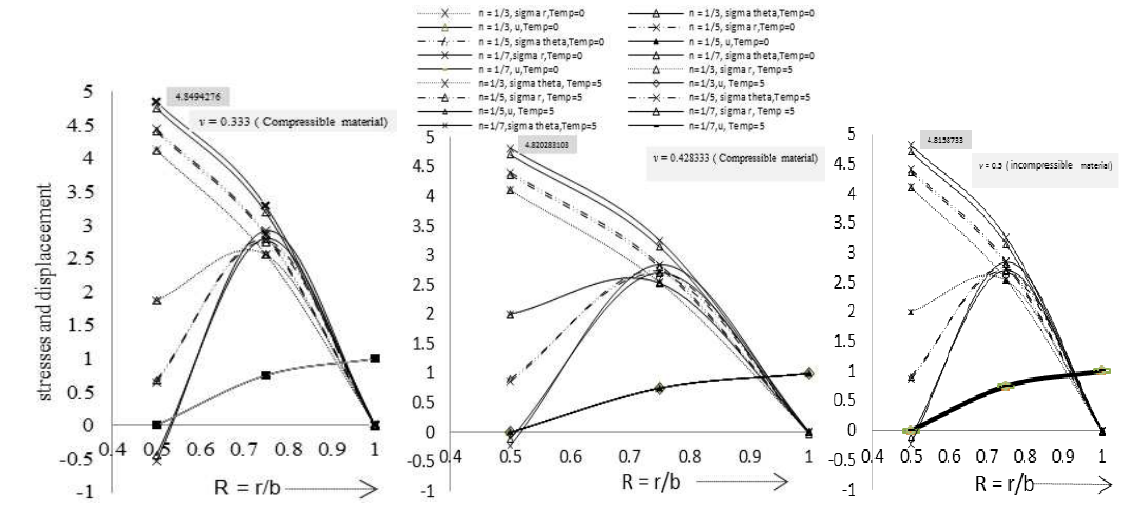
Figure 5(b). Stresses and displacement distribution along the radii ratio R = r / b at angular speed 2 10 W =